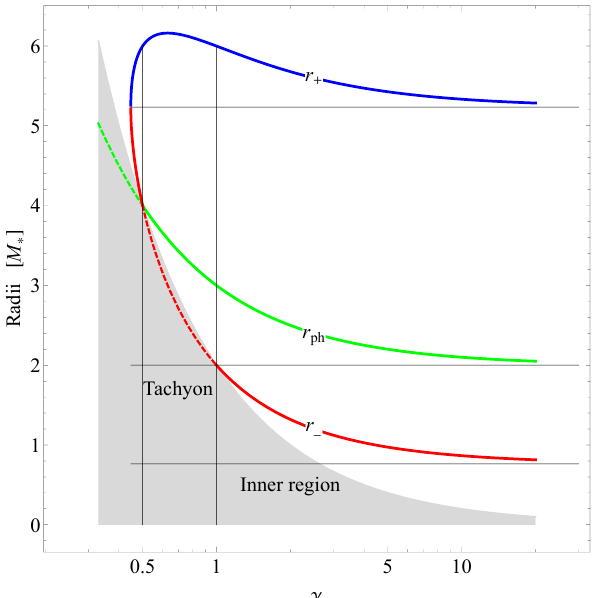
Figure 3. Dependence of the characteristic radii, namely, ISCO, photonsphere and singularity of the spacetime from the γ